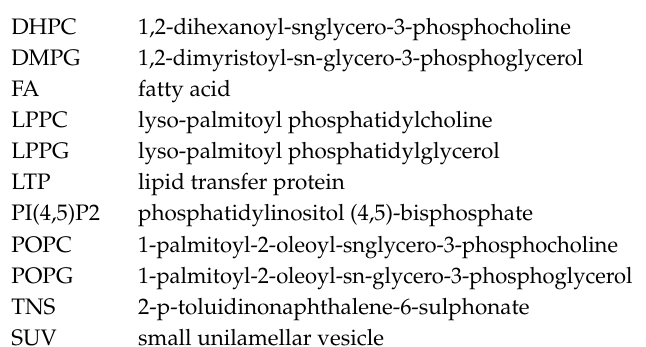
Figure S1: SDS-PAGE analysis of purified recombinant proteins was performed as described [10]. M—protein molecular weight marker; 1—Lc-LTP2; 2—R45A; 3—Y80A; 4—R45A / Y80A; 5—strawberry LTP; 6—ragweed LTP; 7—mugwort LTP, Figure S2: MALDI mass spectra of purified recombinant proteins obtained in a linear